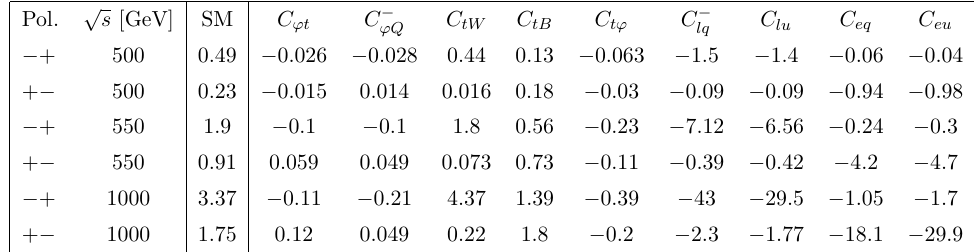
Table 5 . Linear dependence of the cross-section [pb] for the process e (cid:0) e + ! t (cid:22) tH . P ( e (cid:0) ; e + ) = ( (cid:0) 0 : 8 ; +0 : 3) is noted as (cid:0) +, and P ( e (cid:0) ; e + ) = (+0 : 8 ; (cid:0) 0 : 3) is noted as + (cid:0)